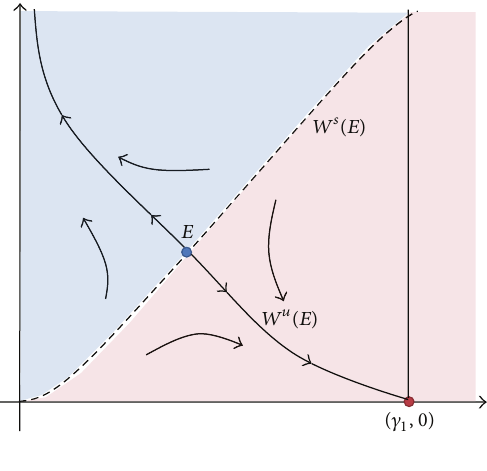
Figure 2: Global dynamics of System